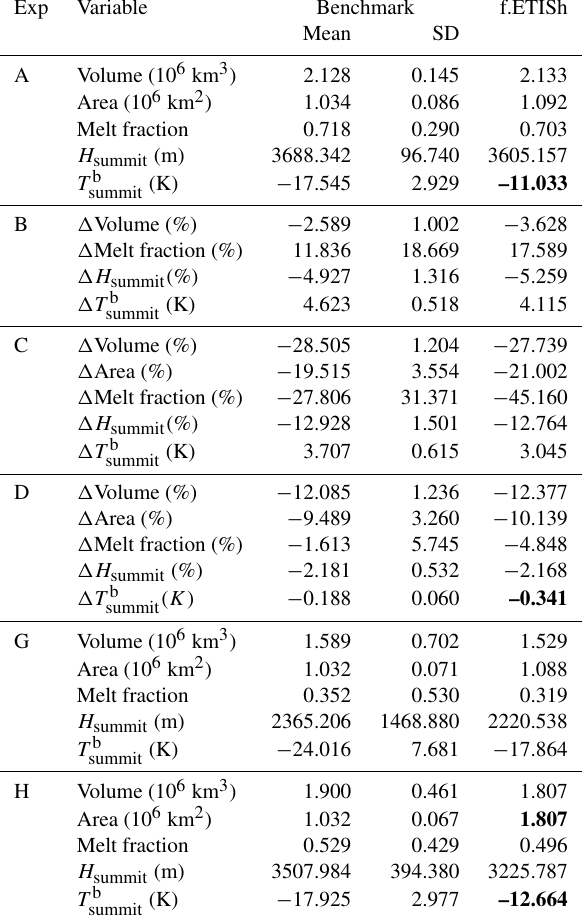
Table B1. Comparison of f.ETISh with the EISMINT-II experi- ments (Payne et al., 2000).